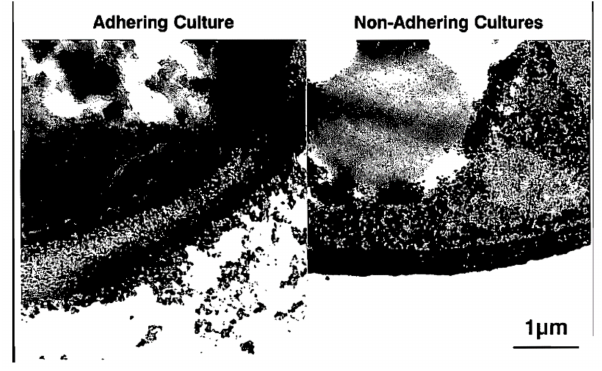
Figure 10. Electron photomicrographs of adhering and non-adhering cultures of Candida albicans (photograph courtesy of L. J. Douglas) [13].